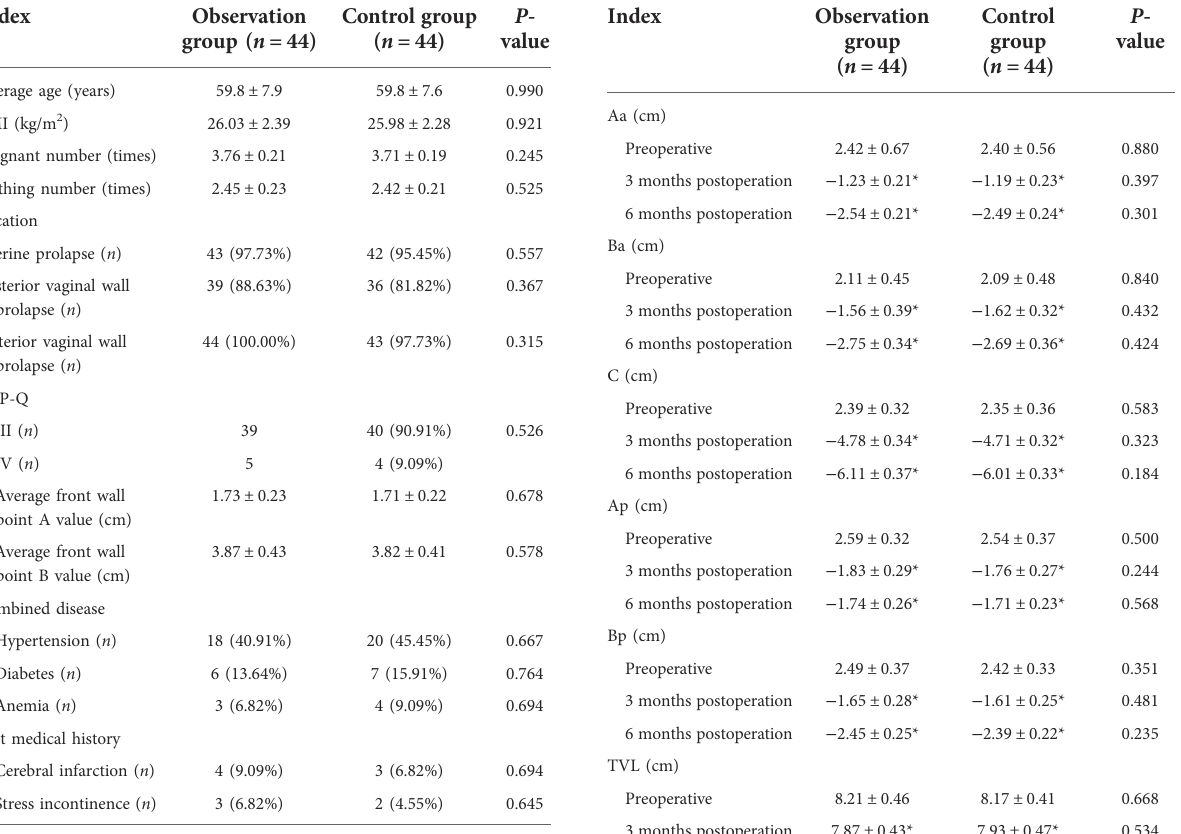
TABLE 1 Comparison of general information between two groups of patients.